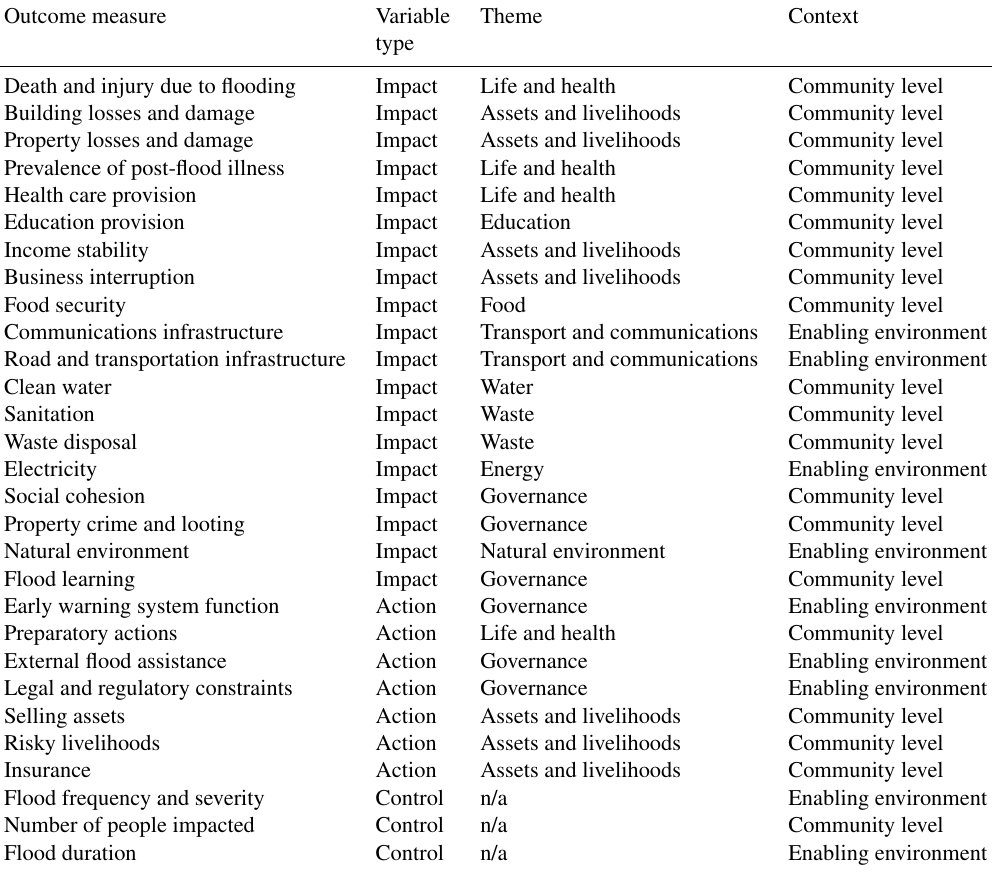
Table B2. The 29 ex post outcome measures, showing variable type and other categorization